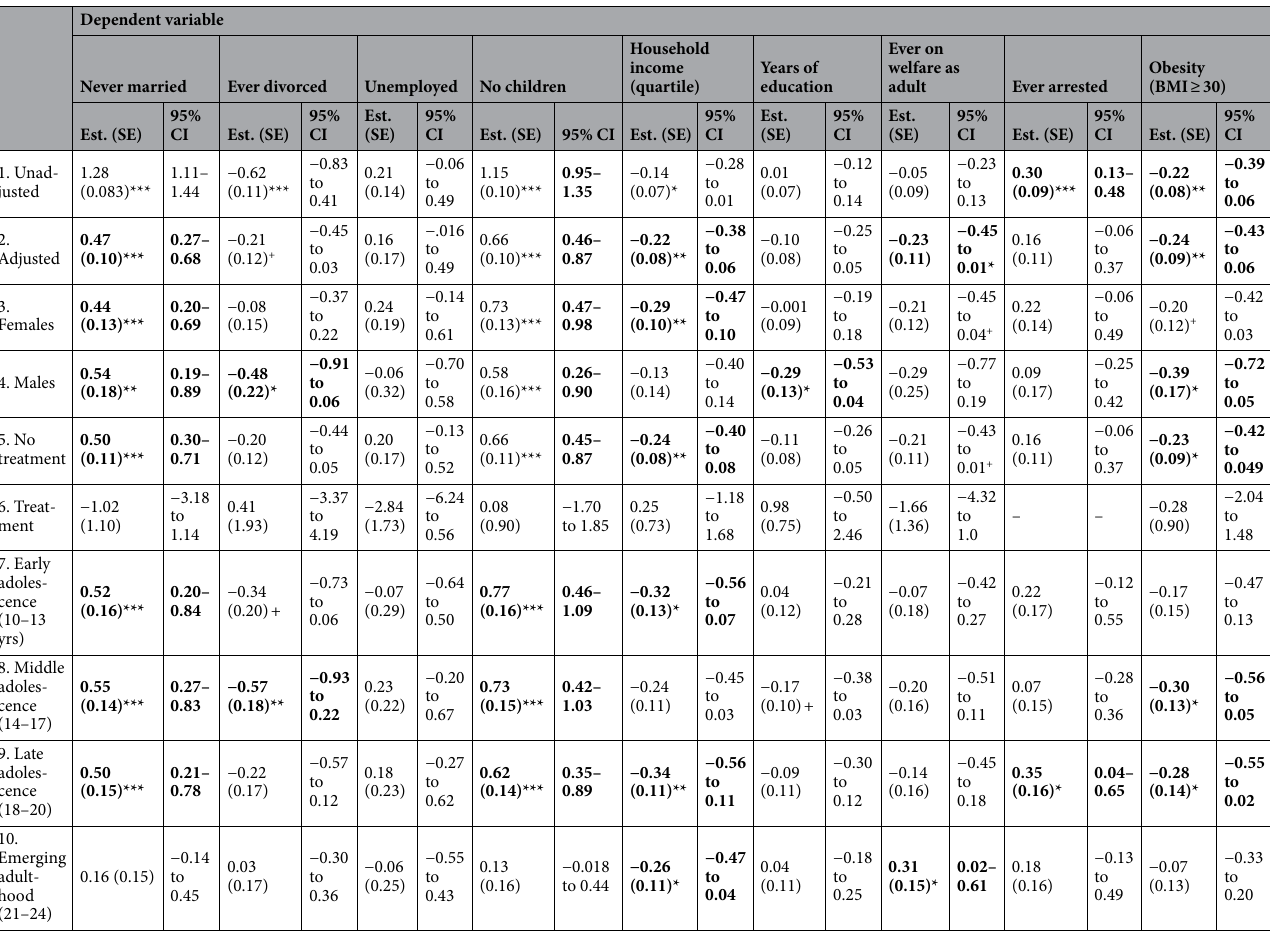
Table 2. Estimated associations between depression during adolescence and social outcomes in adulthood. *** p < .001, ** p < .01, * p < .05, + p < .10; bold typeface indicates statistical significance.